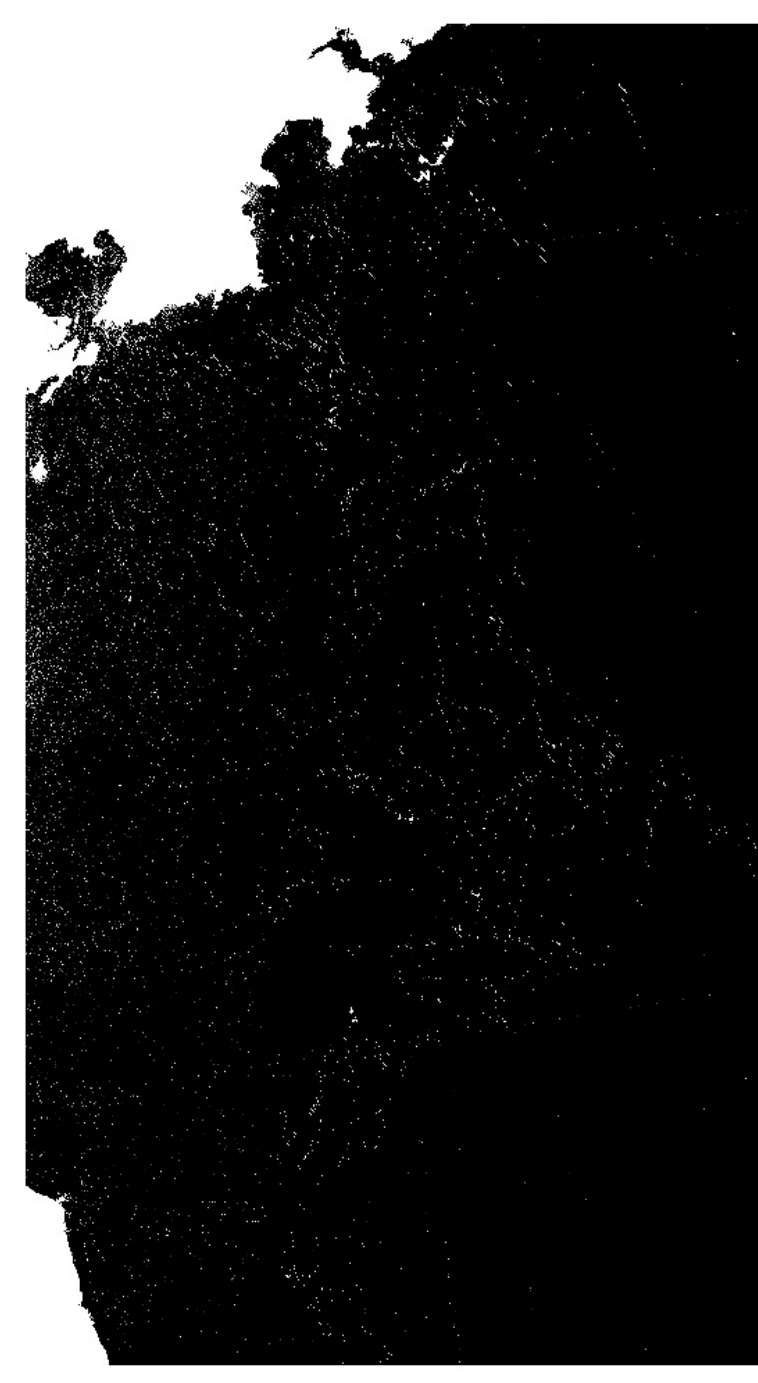
Figure 10. The result of extracting Ulva prolifera with a threshold of − 15 dB.